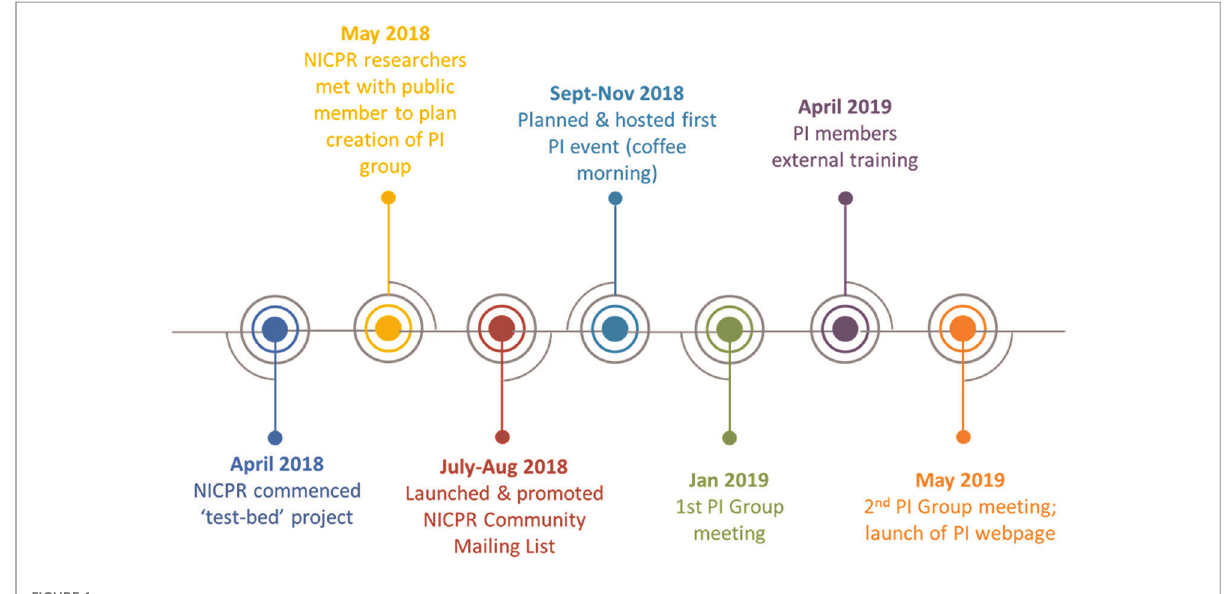
FIGURE 1 Timeline of public involvement group